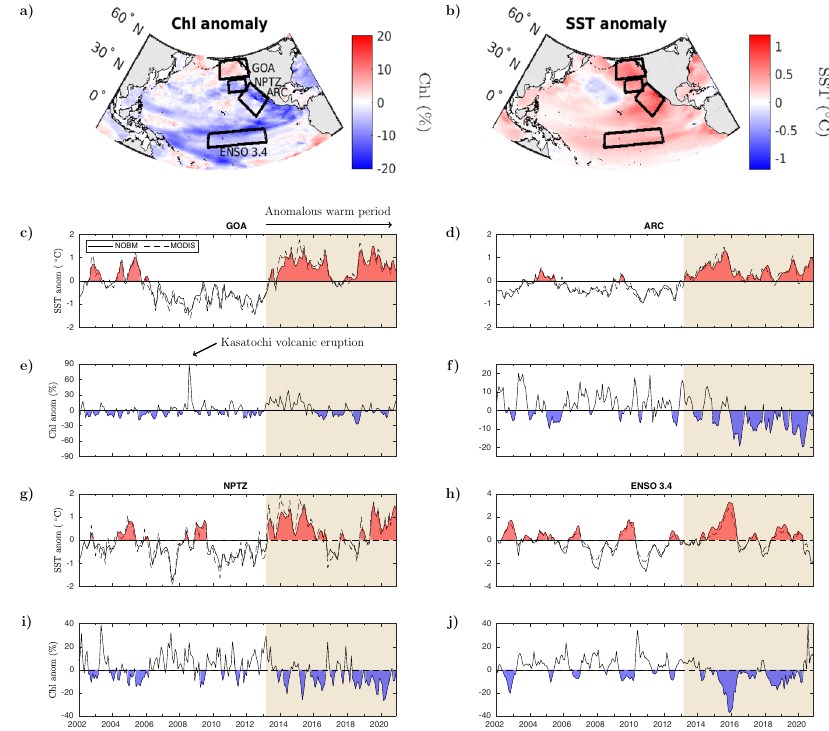
Fig. 1 Chlorophyll (Chl) and sea surface temperature (SST) anomalies in the equatorial and northern Paci fi c. a , b Mean modeled ( a ) Chl and ( b ) SST anomaly over the anomalously warm period between March of 2013 and December 2020. c – j Time series of monthly modeled Chl and SST anomalies between 2002 and 2020 for the four regions of the Paci fi c Ocean analyzed in this study: ( c ) GOA-SST, ( d ) ARC-SST, ( e ) GOA-Chl, ( f ) ARC-Chl, ( g ) NPTZ-SST, ( h ) ENSO 3.4-SST, ( i ) NPTZ-Chl, ( j ) ENSO 3.4-Chl. SST anomalies are shown in degree celsius (°C), and Chl anomalies are shown in percent change (%) relative to the deseasonalized climatological mean. Solid and dashed lines in SST plots are for NASA Ocean Biogeochemical Model (NOBM) output and MODIS Aqua retrievals, respectively. Area of beige background indicates the anomalously warm period initiated by the Blob heatwave in the northeast Paci fi c in March of